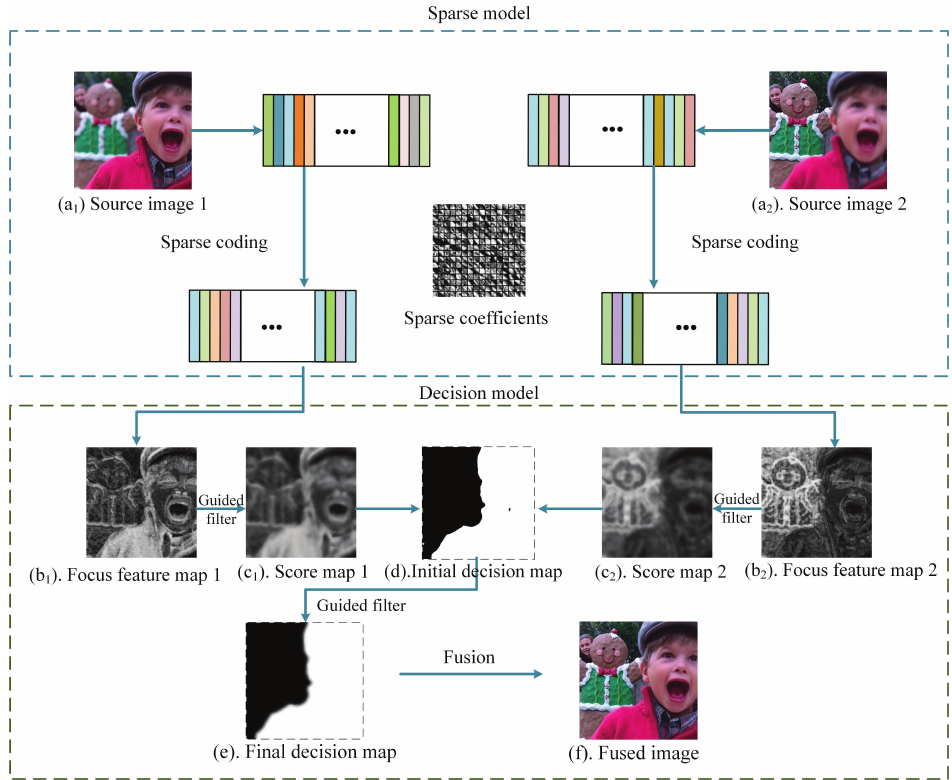
Figure 2. Framework of the proposed